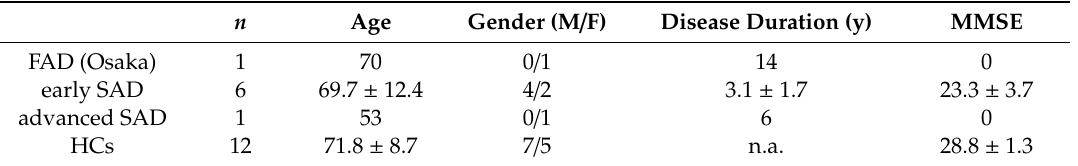
Table 1. Demographic